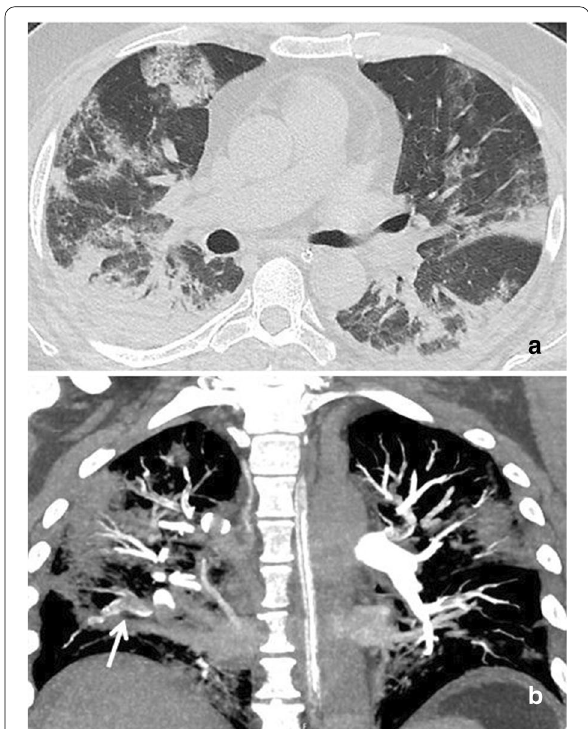
Fig. 3 A 50‑year‑old man with a positive RT‑PCR. a Axial CT image shows moderate COVID‑19 pneumonia manifested by peripherally located GGO and consolidations. b Coronal pulmonary CT angiogram shows multiple filling defects in segmental and subsegmental pulmonary artery branches, clearly seen in the right inferior pulmonary branches (white